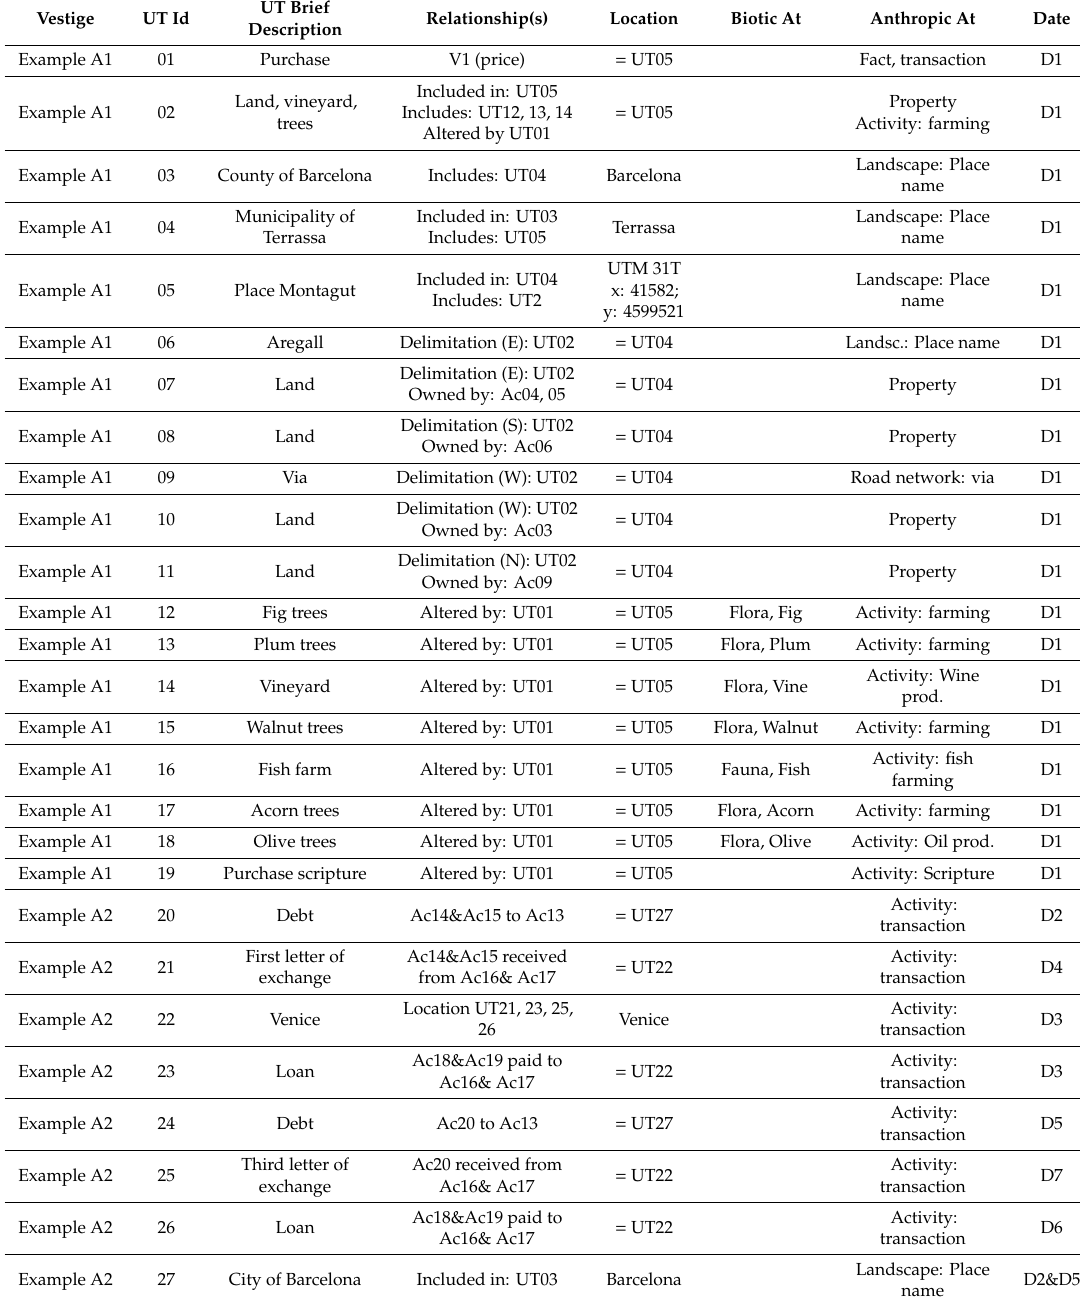
Table A1. Simplified UT dataset gathered from Examples A1 and